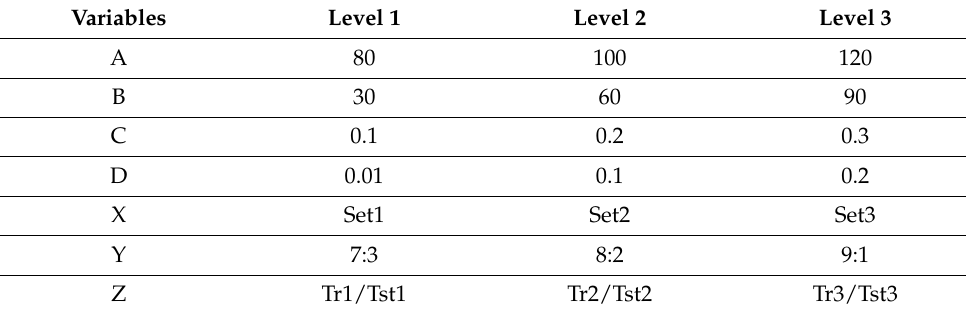
Table 5. Design and noise variables with their assigned